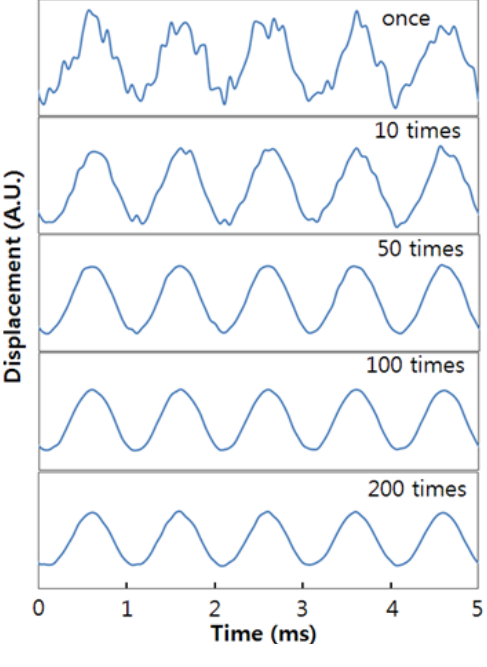
Figure 6. The effect of increasing the number of samples averaged over in measuring the periodic dynamic strain